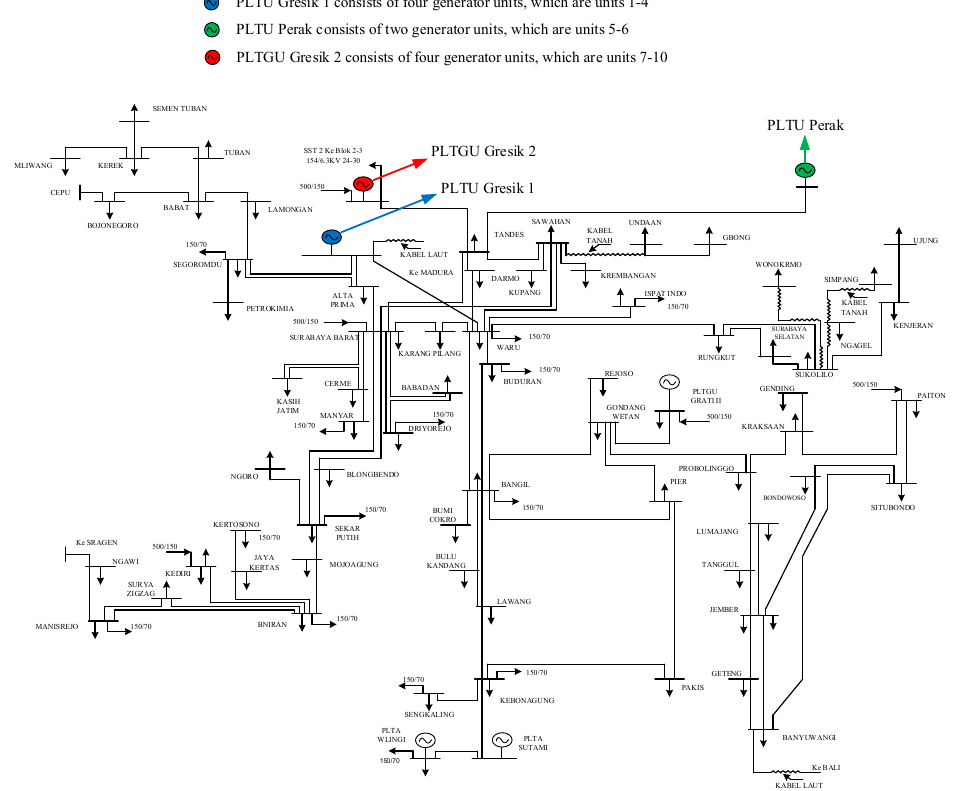
Figure 2. Single line diagram of the East Java 150 kV power system.